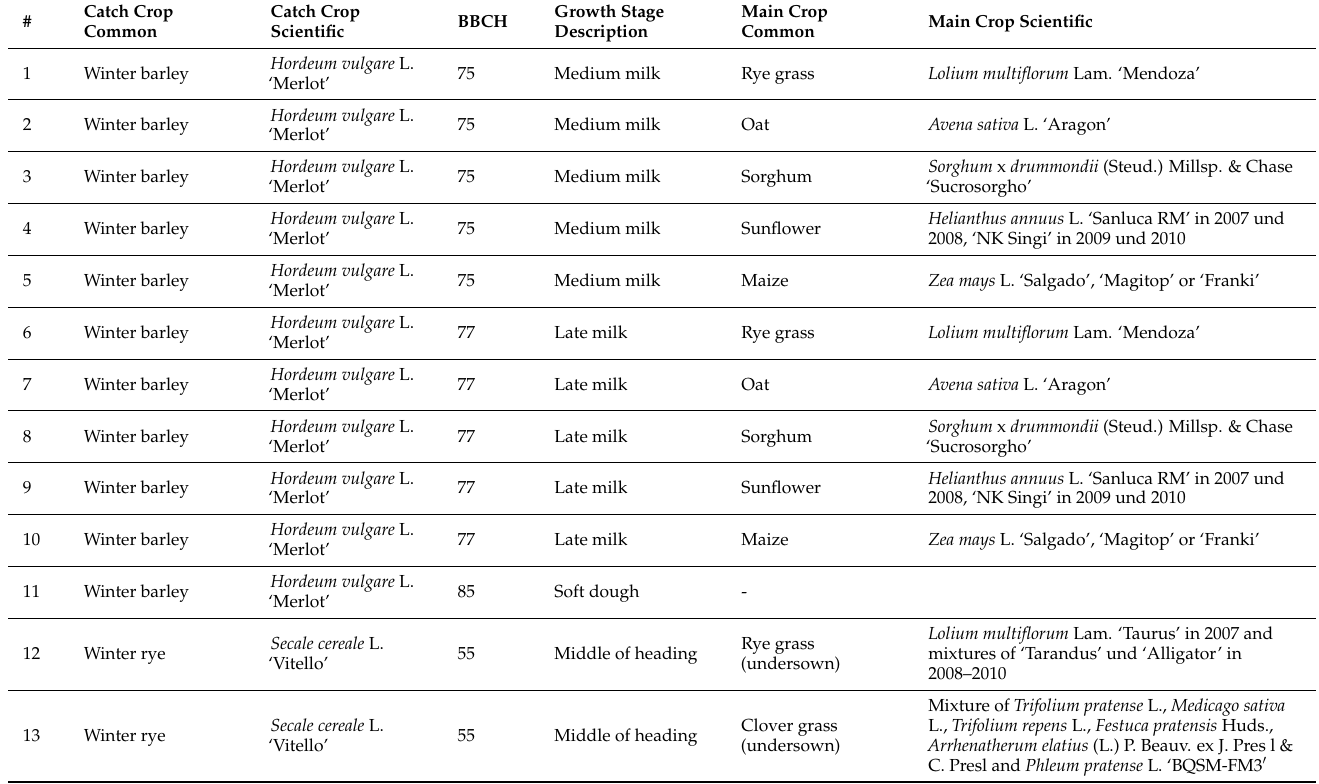
Table A3. Full overview of crops and growth stages (BBCH, [42]) examined in the field